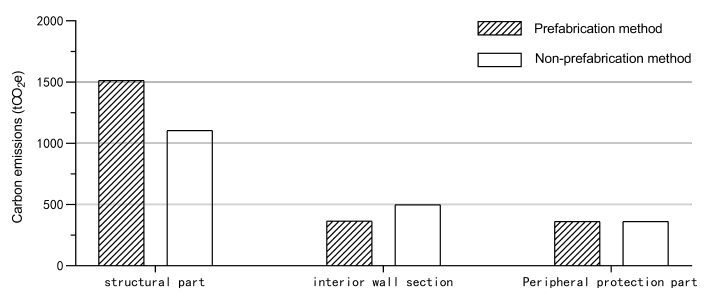
Figure 8. Comparison of material carbon